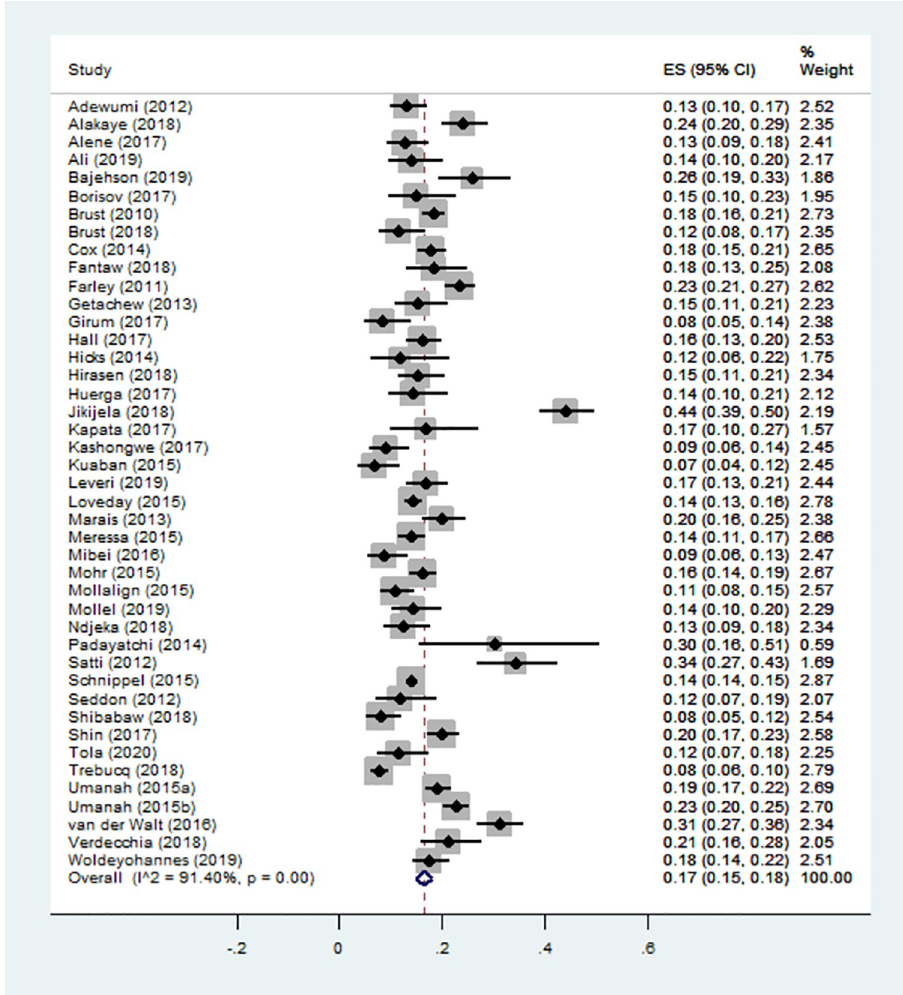
Fig 2. Forest plot for the incidence proportion of